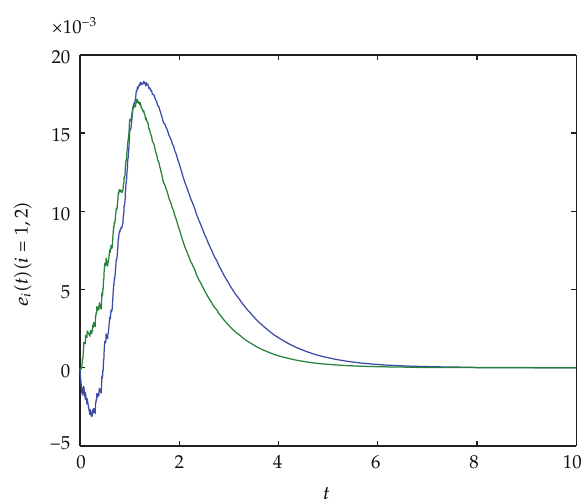
Figure 2: The error curves e i (cid:6) t (cid:7)(cid:6) i (cid:8) 1 , 2 (cid:7) with trigger parameter σ (cid:8) 0 . 1 (cid:6) event-triggered scheme (cid:7) .